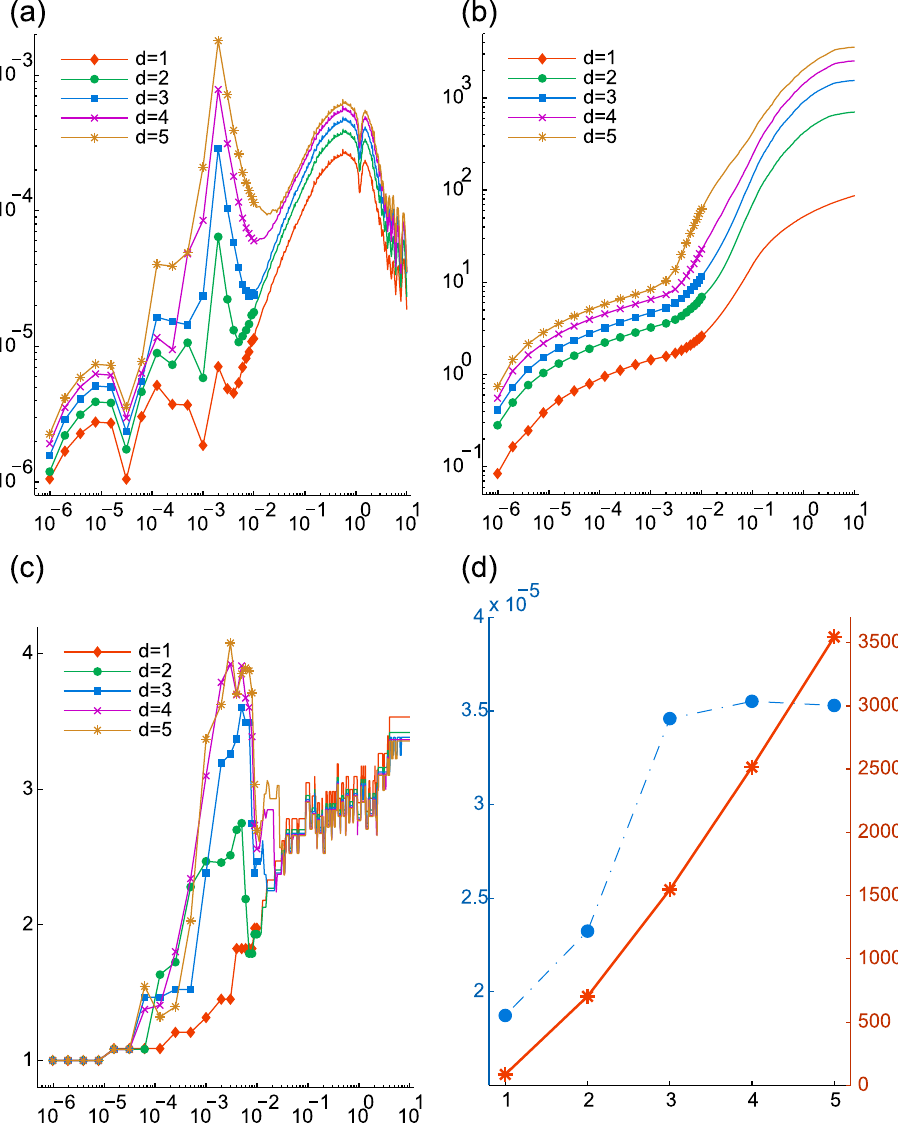
(cid:12) (cid:13) ~ 6 for each d . Markers are omitted for M